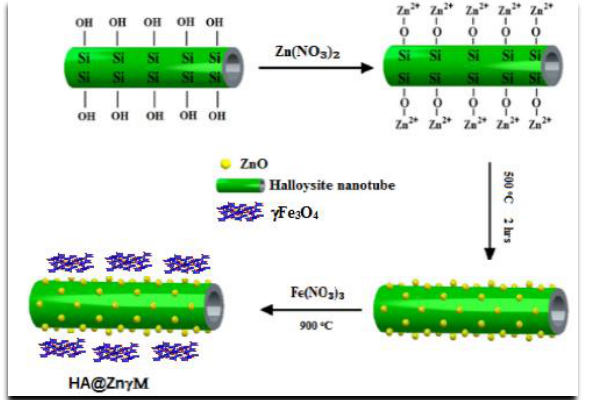
Polymers 2021 , 13 , x FOR PEER REVIEW Figure 2. Scheme of the synthesis of halloysite/Zn  Fe 3 O 4 core/shell (HNTS/Zn  M). Figure 2. Scheme of the synthesis of halloysite/Zn γ Fe 3 O 4 core/shell (HNTS/Zn γ M).